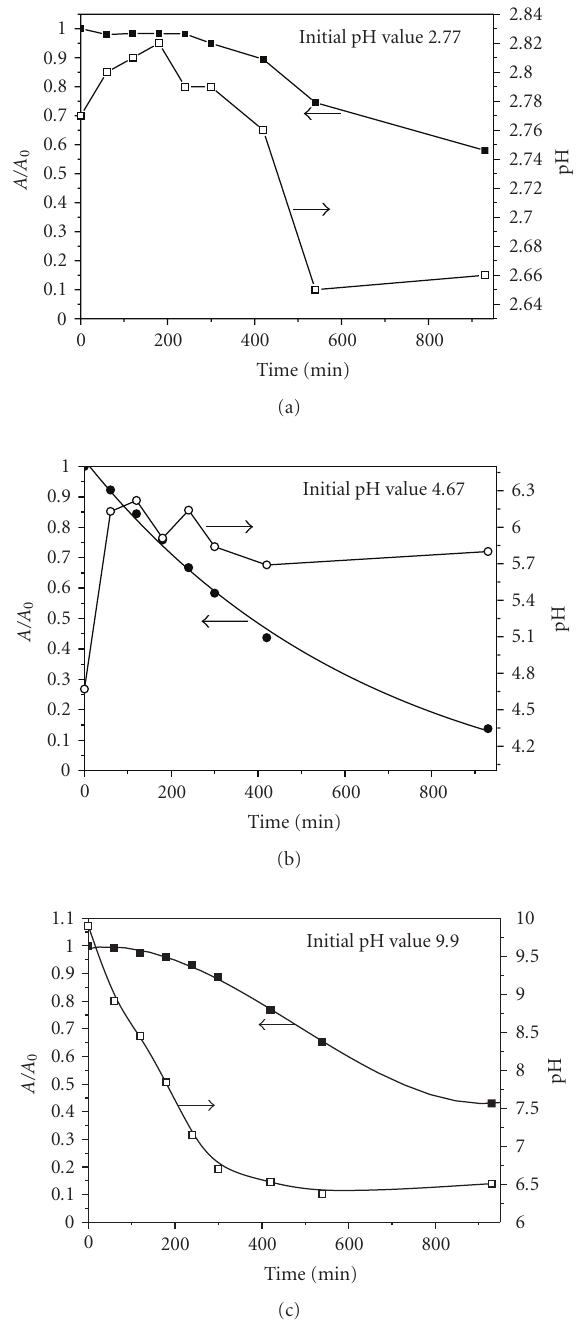
Figure 7: E ff ect of pH variation in the photodegradation rates with pure nanocrystalline titania films (a) in acidic pH; (b) in natural pH of AZS in water; (c) in alkaline pH